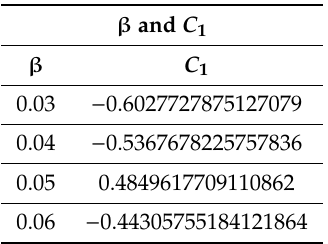
Table 1. Values of β and C 1